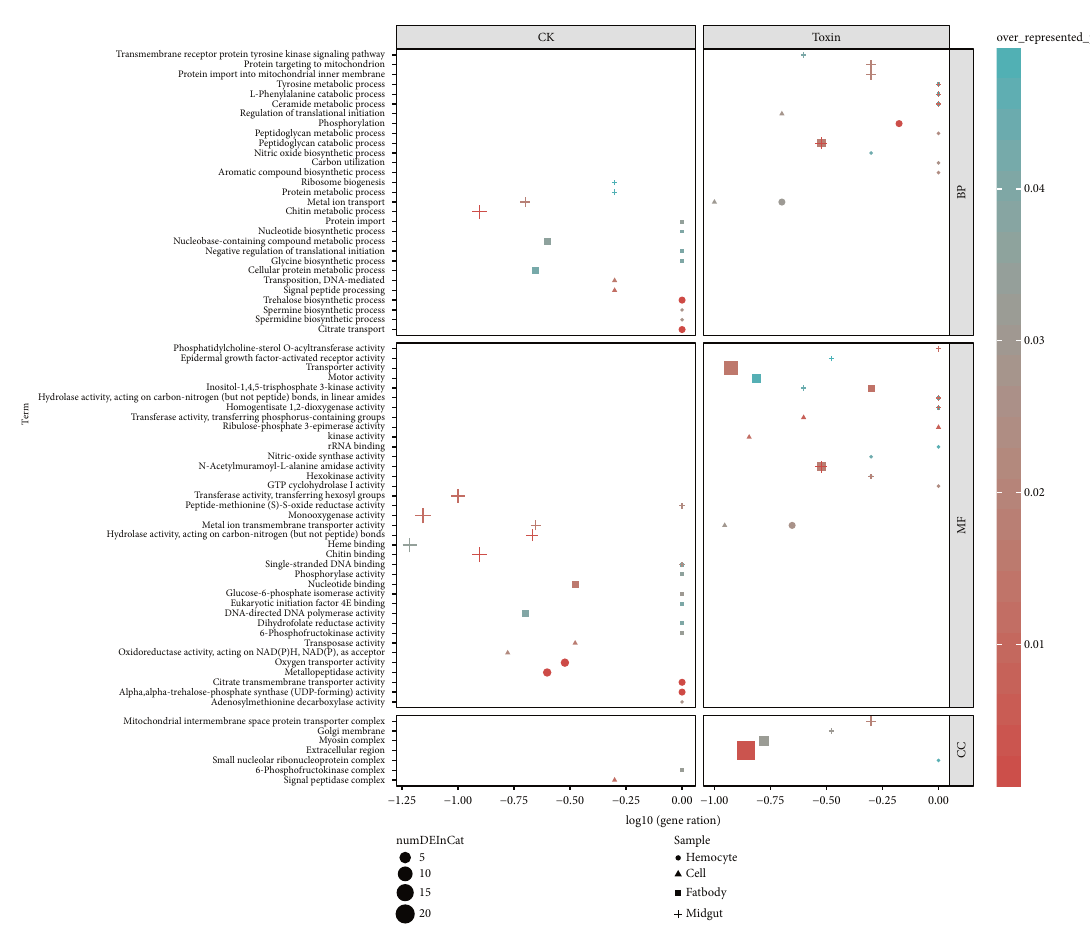
Figure 5: Bubble plot of Gene Ontology (GO) term enrichment results. Gene ratio is calculated as the number of genes in a category divided by the number of genes in the background.